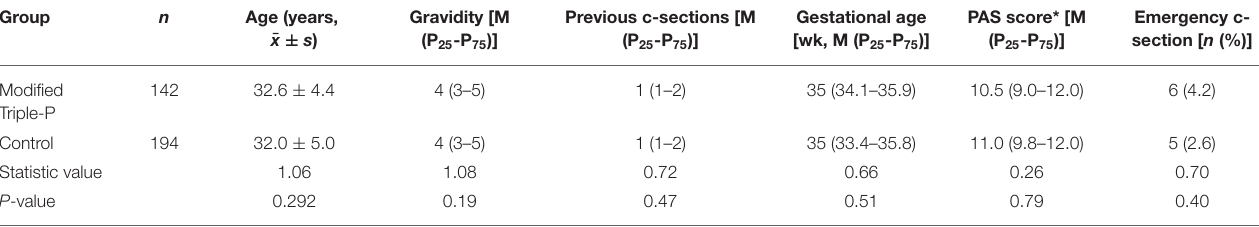
TABLE 1 | Comparation of demographic characteristics of the patients with placenta increta/percreta in two